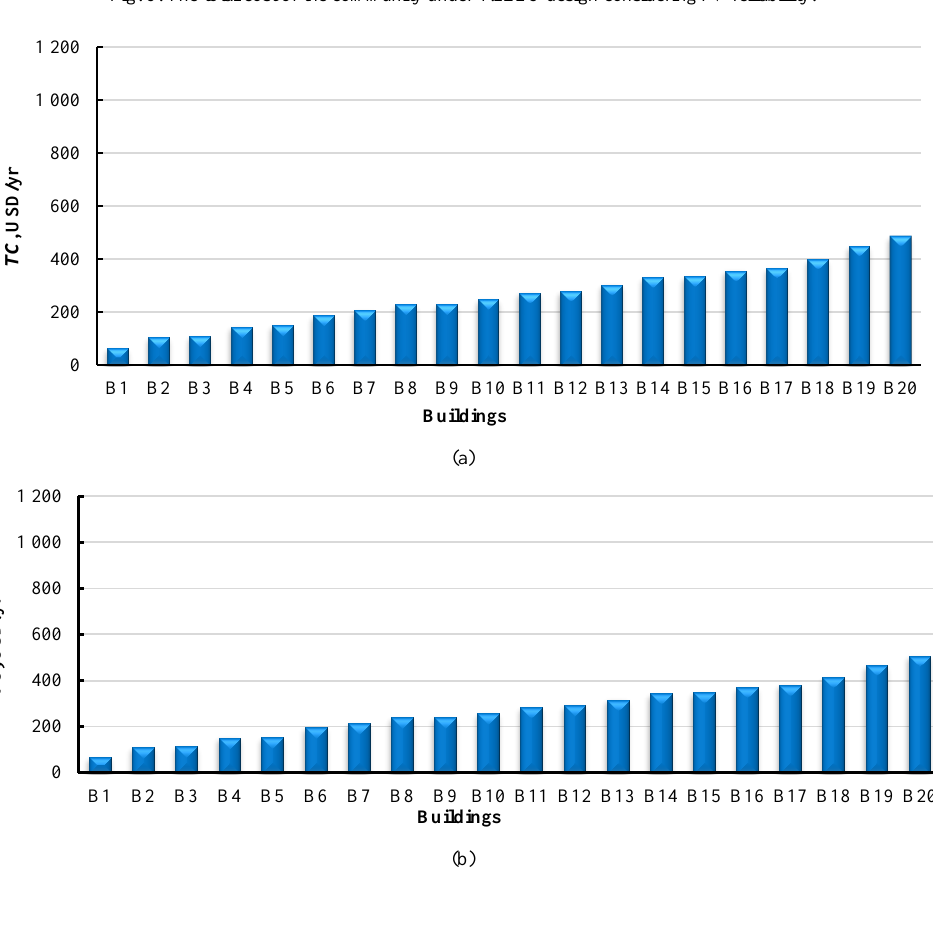
Fig. 9. The total cost of the community under 1.2ZEC design considering PV